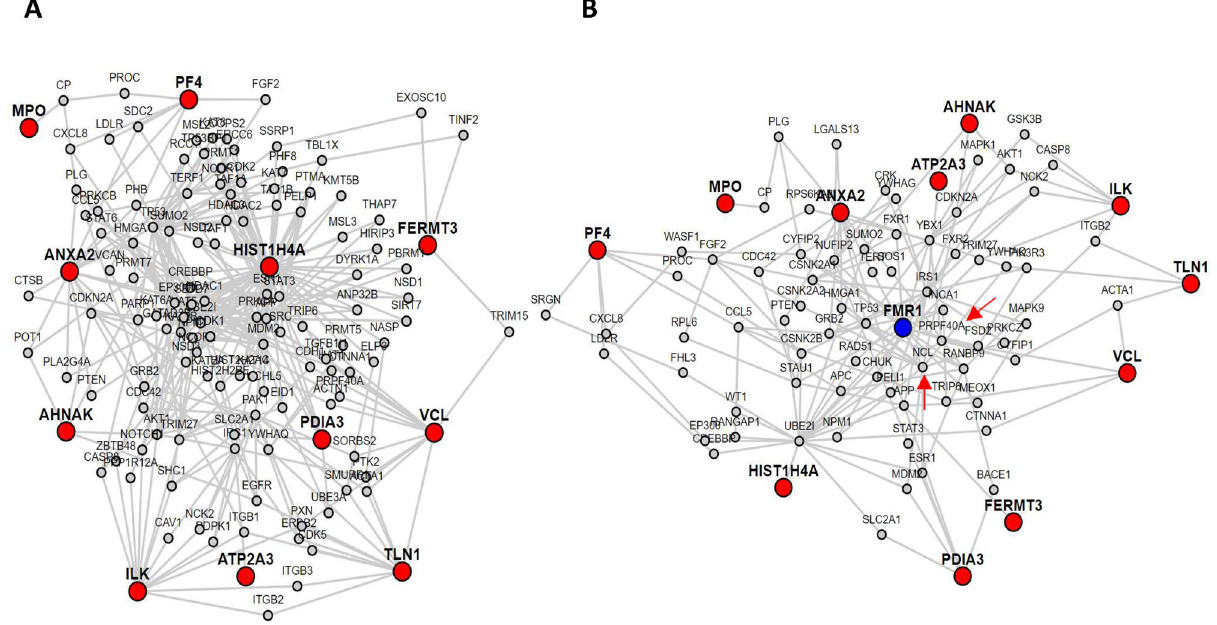
Figure 5. Protein–protein interaction networks of 11 proteins found differentially expressed in both nascent and total proteome of fragile X PBMCs. ( A ) Interaction network corresponding only of the 11 candidates (red). ( B ) Interaction network generated with the 11 candidate proteins (red) and FMRP (blue) set as target. The NCL and PRPF40A proteins, which are found deregulated in FXS nascent proteome, are also present in this network (red